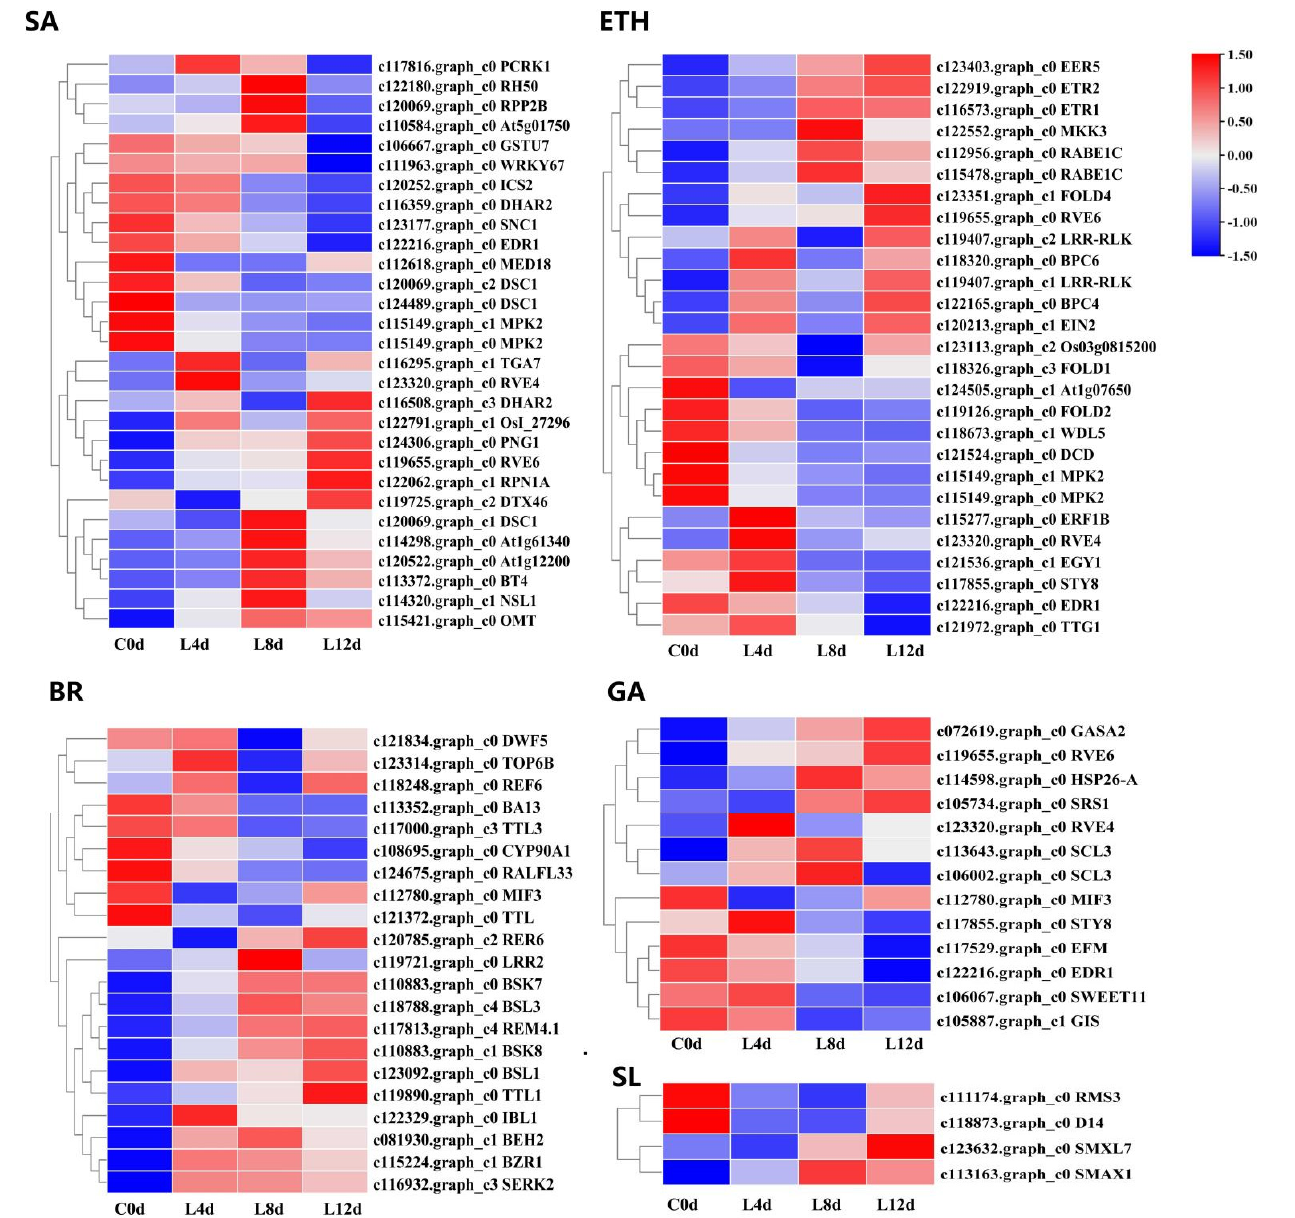
Figure 7. Heat map diagram showing the expression profiles of the SA ‐ , ETH ‐ , BR ‐ , GA ‐ , and SL ‐ DEGs under low ‐ temperature conditions. ‘Huaizhi’ litchi trees were grown in a chamber with 22 °C/17 °C (day/night temperature, 12 h day and 12 h night) as the normal temperature. Temperatures dropped from the normal one to 2 °C for 4 d, and then were maintained at 2 °C for another 8 d. C0d, L4d, L8d, and L12d mean the leaves samples at 0 d, 4 d, 8 d, and 12 d of treatment. Fragments per kilobase of transcript per million mapped reads (FPKM) values were normalized to Z ‐ score.